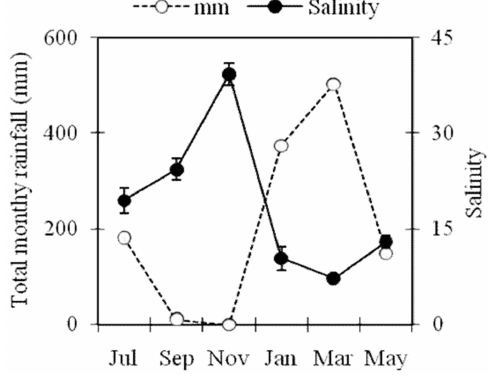
Fig. 2 – Seasonal variation of salinity (means ± SD) in relation to total monthly rainfall (ANA 2006) in the Curuçá estuary.